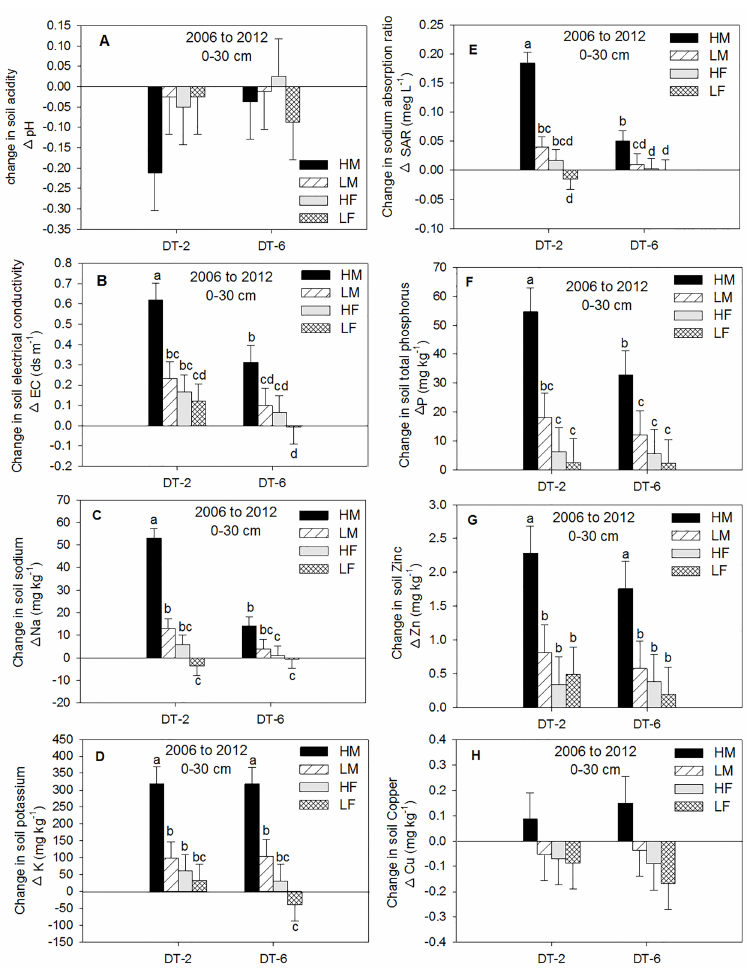
Fig 4. Change in soil chemical properties (A-H) from 2006to 2012 at 0–30 cm depth as influenced by at different N and deep tillage (DT). DT-2 represents biannualdeep tillage and manure(M) addition;DT-6 represents deep tillage and M additiononce every six years; HM treatment represents beef manureaddition at three times the recommended N (high) rate; LM treatment represents beef manure additionat the recommended (low) rate; HF treatment represents inorganicfertilizer (urea) additionat doublethe recommended N (high) rate; LF treatment represents inorganicfertilizer (urea) additionat the recommended (low) rate; C treatment representsno nitrogenaddition(control). The error bars representstandard errors of the mean. The different lowercaseletters represent significantdifferencesamong N treatments (P < 0.05).